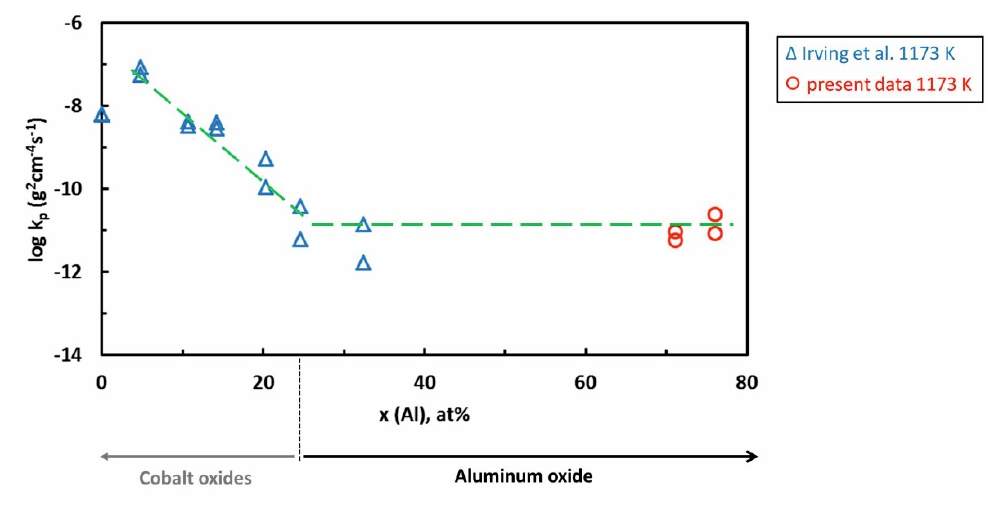
Figure 13. Variation of parabolic rate constants of Al-Co alloys with increasing aluminum atomic fraction.